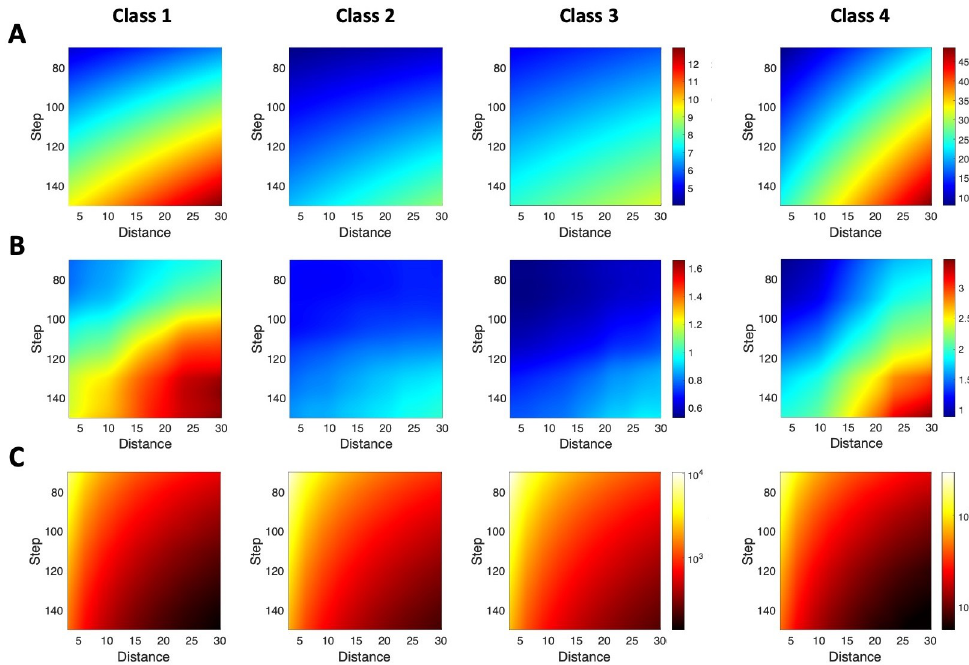
Fig 7. Mean absolute error for axon length estimation by planes-based stereology. A . The mean absolute error (in % of the real axon length indicated by colors–see color bar) is shown for different values of the distance between planes and the step between sampling boxes, and for axon classes 1 to 4 (columns). Note that the color bar is the same for classes 1, 2, and 3. B. Accuracy of the mean error estimation as maximum error estimation at 95% confidence (in % of the real axon length indicated by colors; same color bar for classes 1, 2, and 3). C . Mean effort, quantized by the mean number of intersections, required to estimate the axon length with different values of the distance between planes and the step for axon classes 1 to 4. Colors denote the number of intersections (in logarithmic scale; color bar is the same for classes 1, 2, and 3). Mean intersection values were obtained through linear interpolation from estimation for distance values in 3, 6, 9, ... ,30 μ m and step values in 70, 80, ... ,150 μ